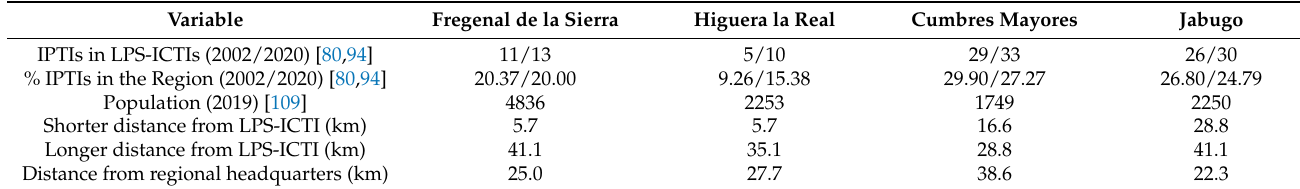
Table 2. LPS-IPTI selection